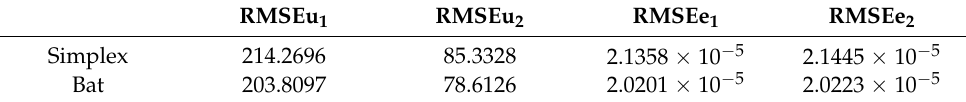
Table 3. Performance of the